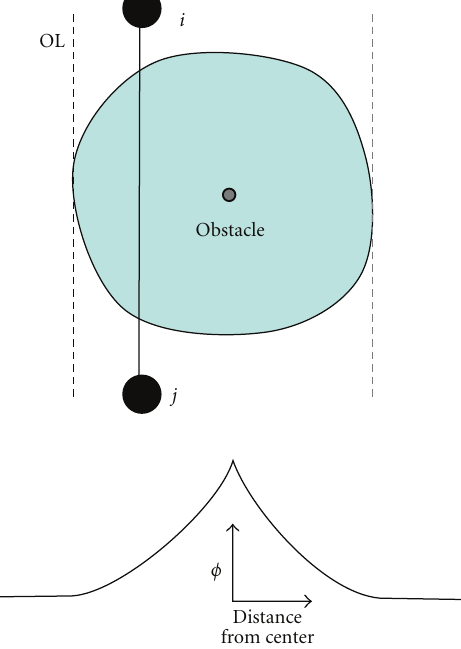
Figure 4: The left frame illustrates a situation where line of sight is not maintained (no straight-line homotopy between paths; loop is not homotopic to constant loop). The right frame shows two paths that maintain line of sight (straight-line homotopy between paths; loop is homotopic to the constant